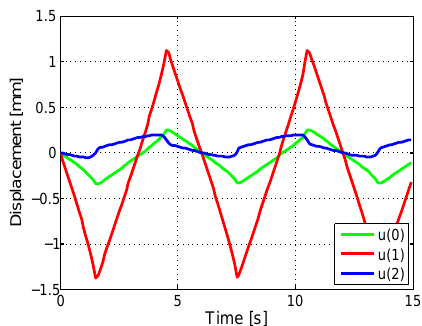
Figure 4. Displacement of point E in x , y and z directions according to